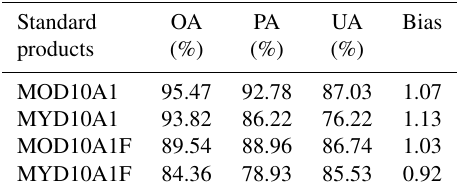
Table 6. Accuracies of SCE products derived from MOD10A1, MYD10A1, MOD10A1F, and MYD10A1F using the same ground